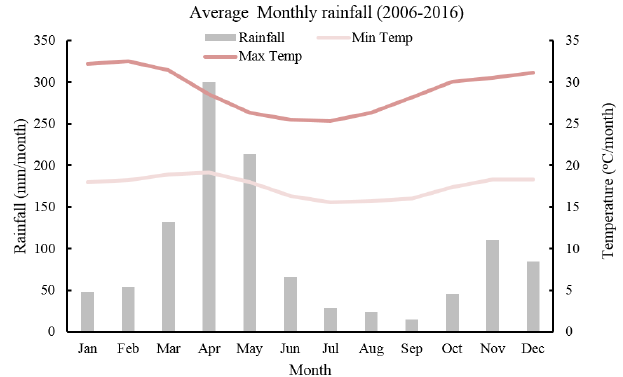
Figure 2. Monthly average rainfall (mm) and temperature of the Kikuletwa basin ground rainfall